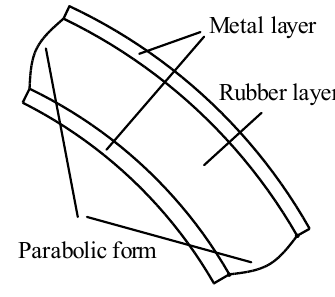
Figure 2. The parabolic form of rubber